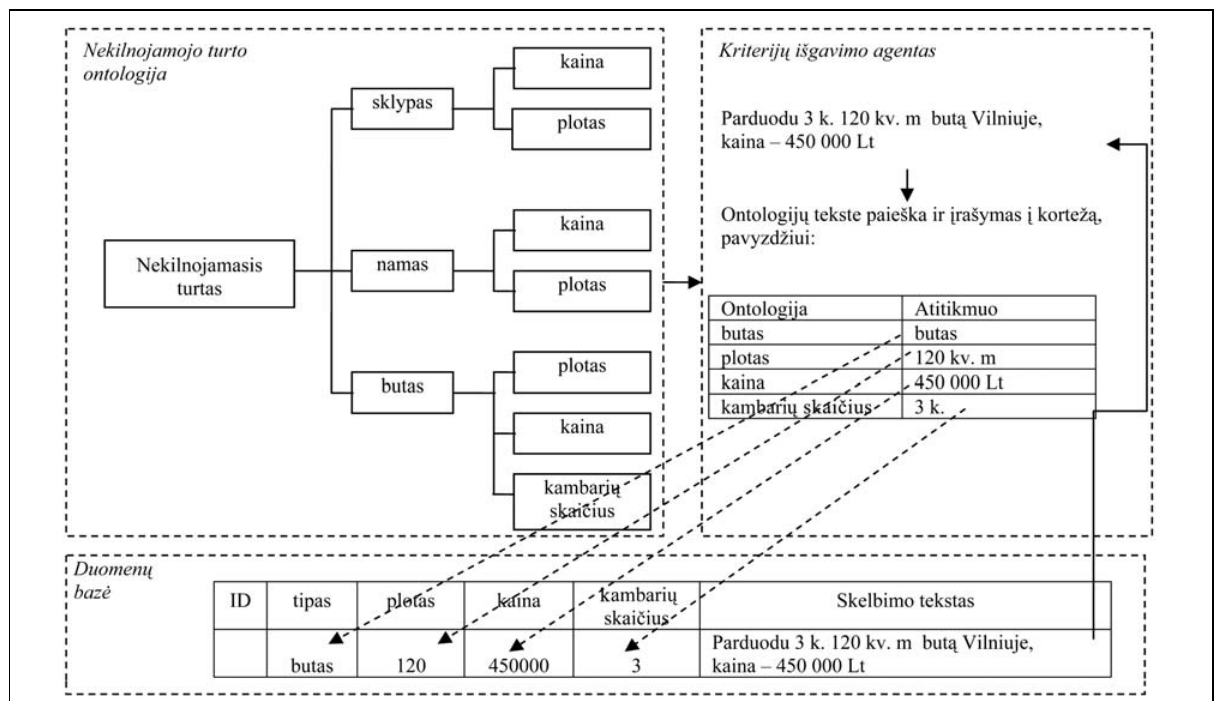
Fig 4. Application of realty ontology for criteria